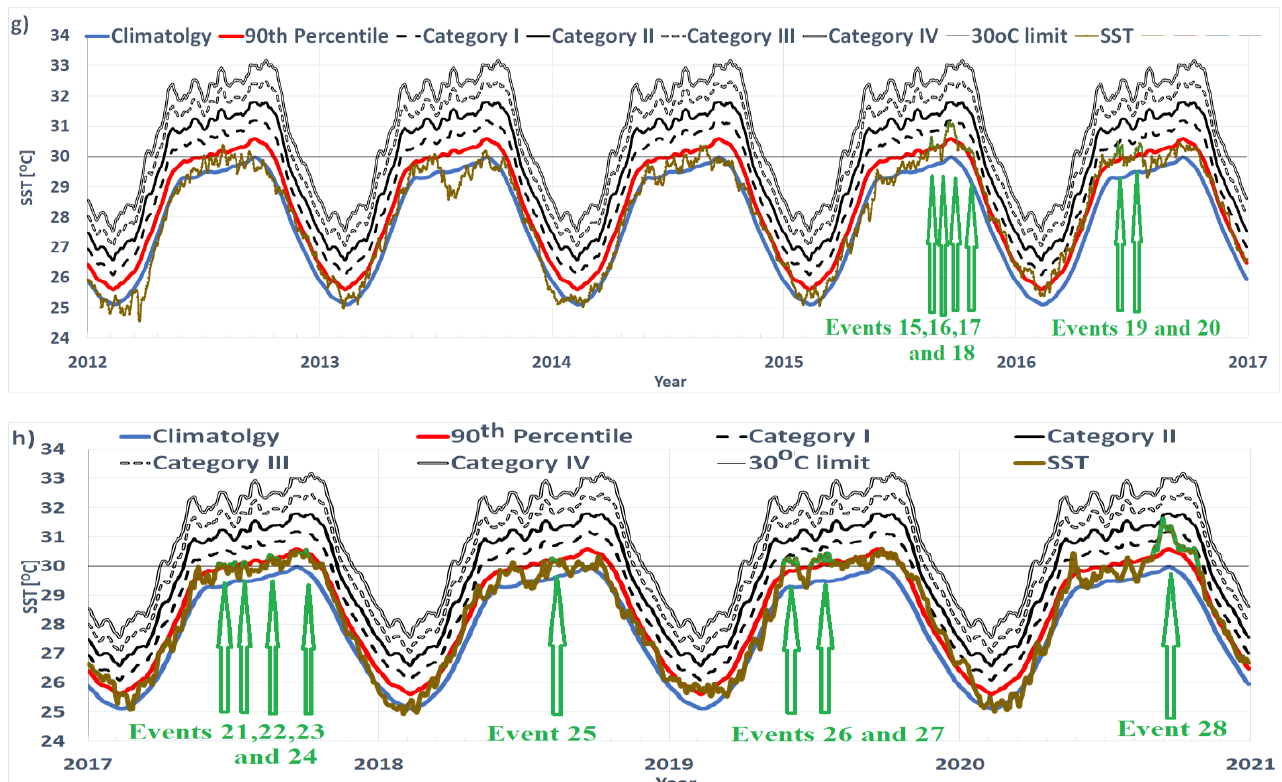
Figure 4. Marine heat waves over the Red+: a categorization diagram showing the observed temperature time series (dashed line) for each year from 1982 to 2020 (1982–1986 ( a ), 1987–1991 ( b ), 1992–1996 ( c ), 1997–2001 ( d ), 2002–2006 ( e ), 2007–2011 ( f ), 2012–2016 ( g ), and 2017–2020 ( h )), the long-term regional climatology and the 90th percentile climatology together with the four categories. Table 1. The characteristics of the recent MHWs over the Red+. The entry for each event lists date of peak intensity, the total duration of the event (first day, last day and total days), the category, maximum intensity (I max , ◦ C above the climatological mean) on that date, mean intensity (I mean ) along event’s duration, the cumulative intensity (I cum = I mean * event duration) and the proportion (p) of time spent in each of the four MHW categories along event’s duration. As the presence of “gap days” connecting successive events, the proportions do not always sum up to 100%.